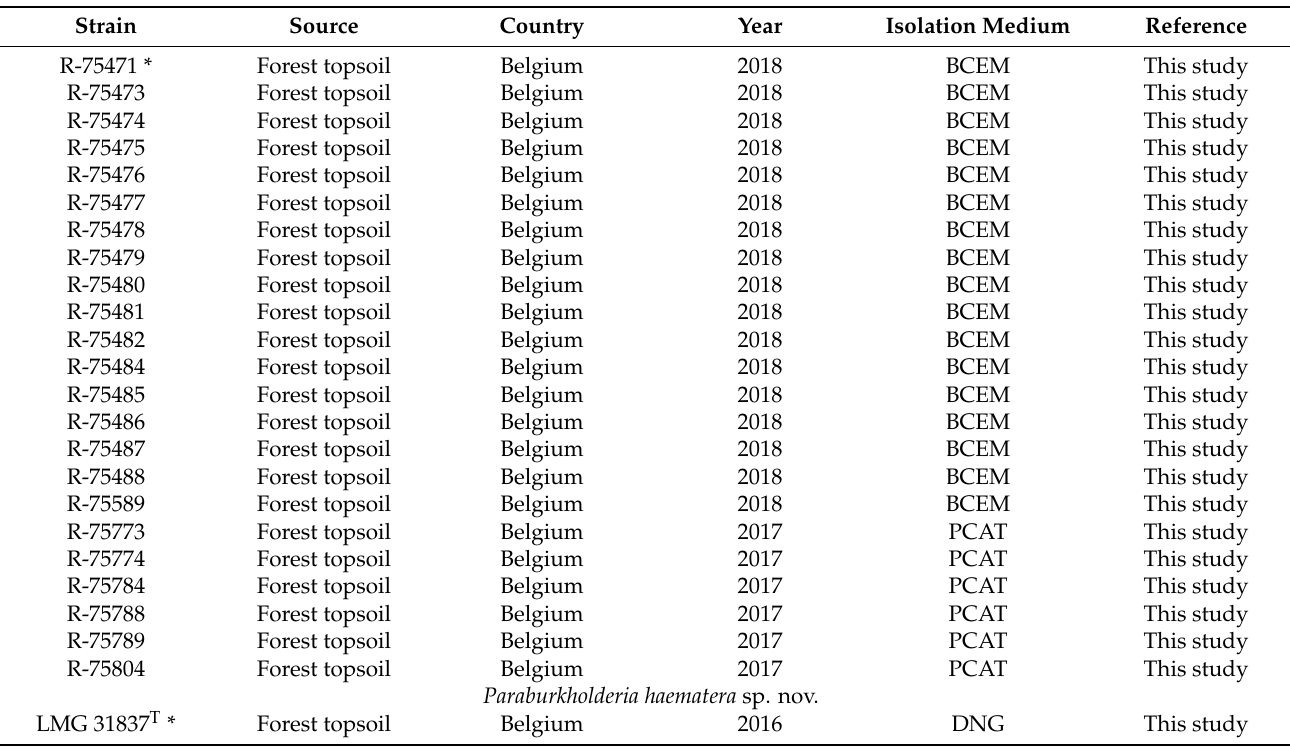
A subset of 18 representative isolates, based on their position in the recA gene based phylogenetic tree, was selected for whole genome sequence analysis. In addition, we also tree based on the analysis of 107 single-copy genes, the 18 isolates again represented a single line of descent together with the P. aspalathi , P. madseniana , P. sediminicola , P. caffeinilytica , P. solitsugae and P. elongata type strains (Figure 2). Seventeen isolates grouped in three clusters while isolate LMG 31837 T again occupied a well-separated position. The